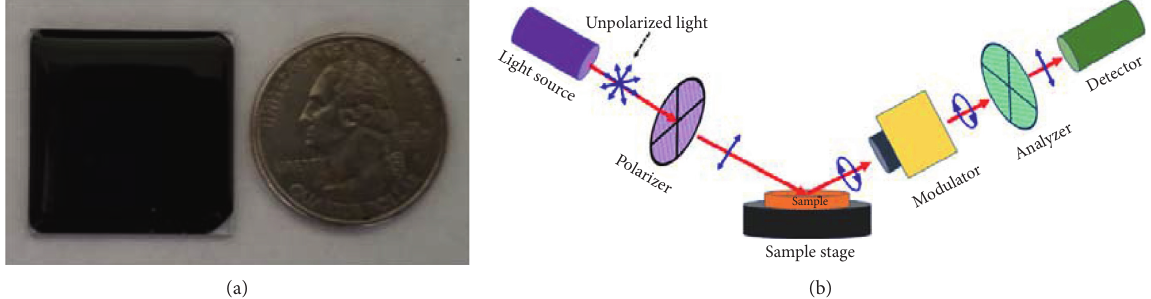
Figure 6: Ellipsometry: (a) prepared sample and (b) schematic diagram of spectroscopic ellipsometry system [20].